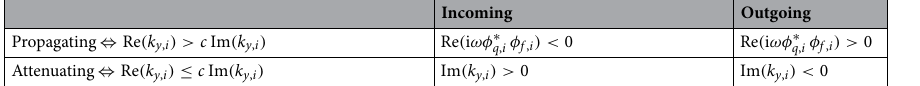
Table 2. Properties of eigenvalues and associated waves. The expression Re ( i ωφ ∗ q , i φ f , i ) denotes the power flow of the i th